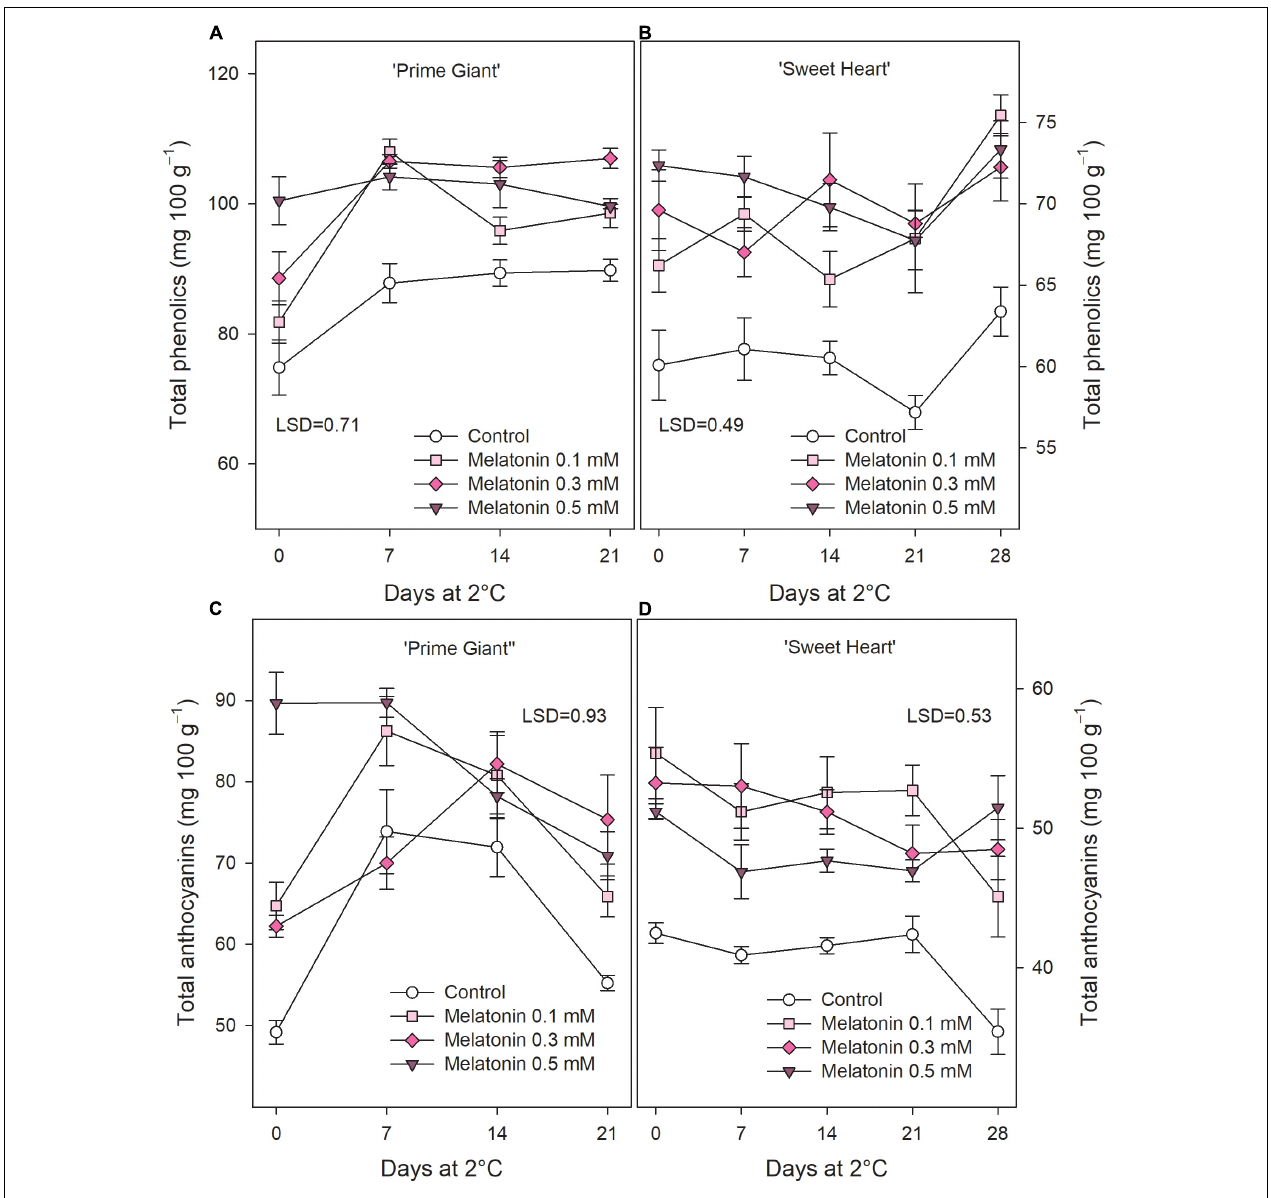
FIGURE 4 | Total phenolics (A,B) and total anthocyanins (C,D) for ‘Prime Giant’ and ‘Sweet Heart’ cultivars during storage at 2 ◦ C as affected by melatonin pre-harvest treatments. Data are the mean ± SE of three replicates. LSD values at ( p < 0.05) are shown in each